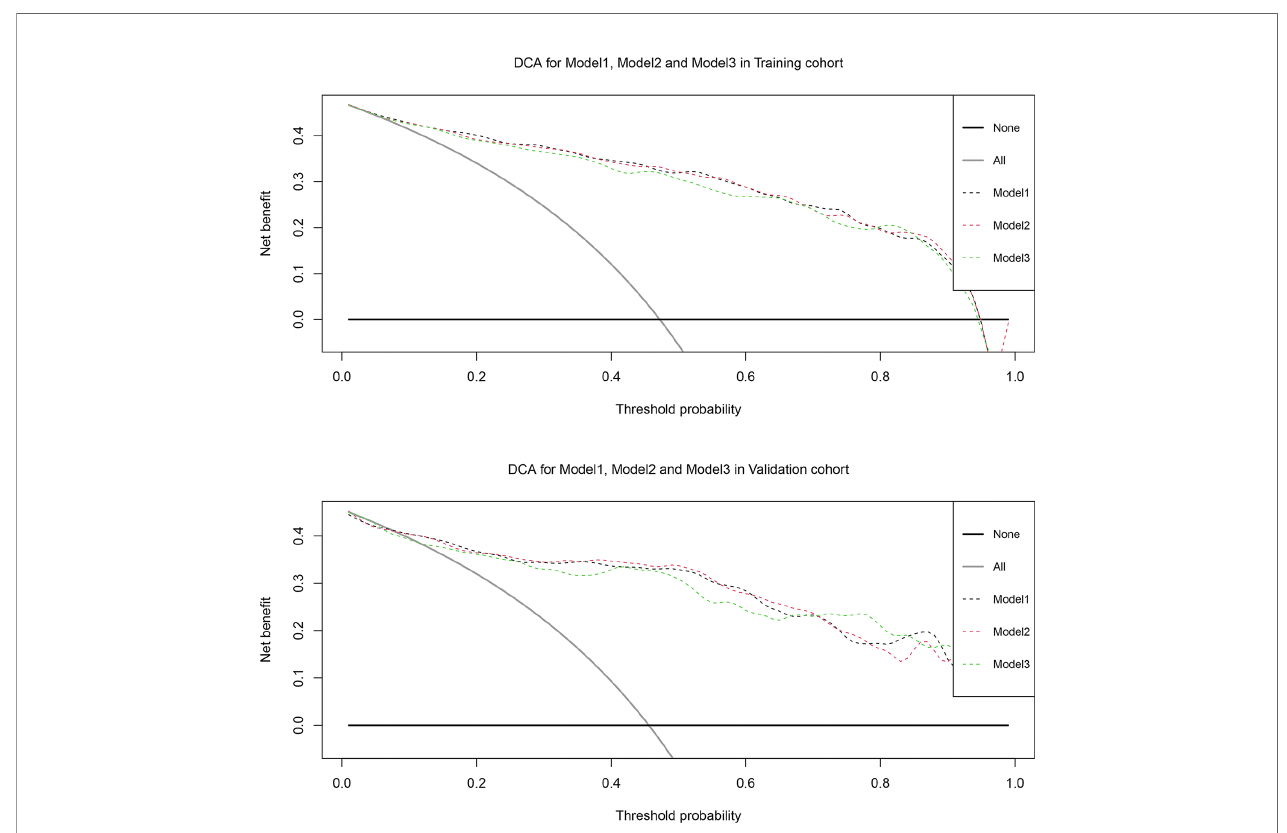
FIGURE 6 | Decision curve analysis of the effect of the nomogram based on model 1 for predicting prostate cancer in training cohort and validation cohort. Net bene fi t of nomogram is plotted with threshold probabilities for prostate cancer compared with the strategies of treating all patients or no one. The decision curve illustrated net bene fi t was improved when threshold probability >